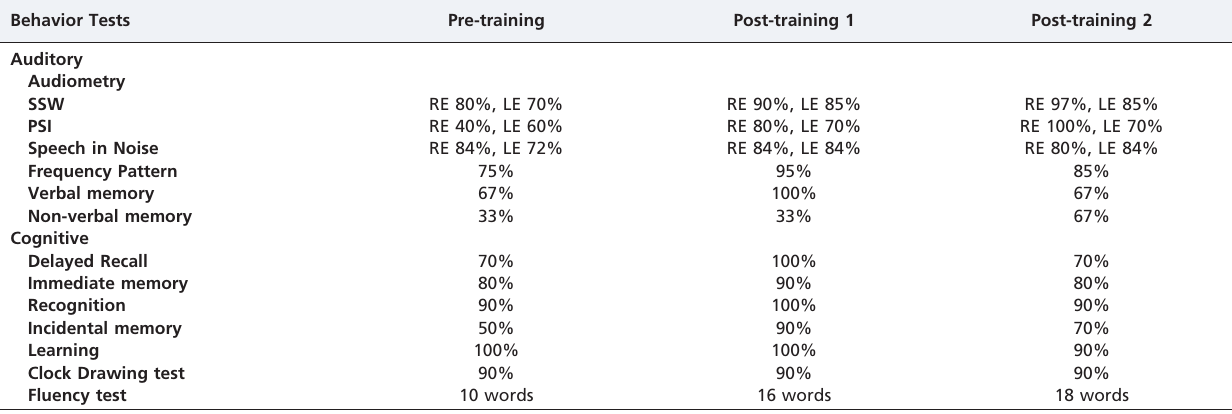
Table 1 – Auditory processing and cognitive abilities pre- and post-treatment.